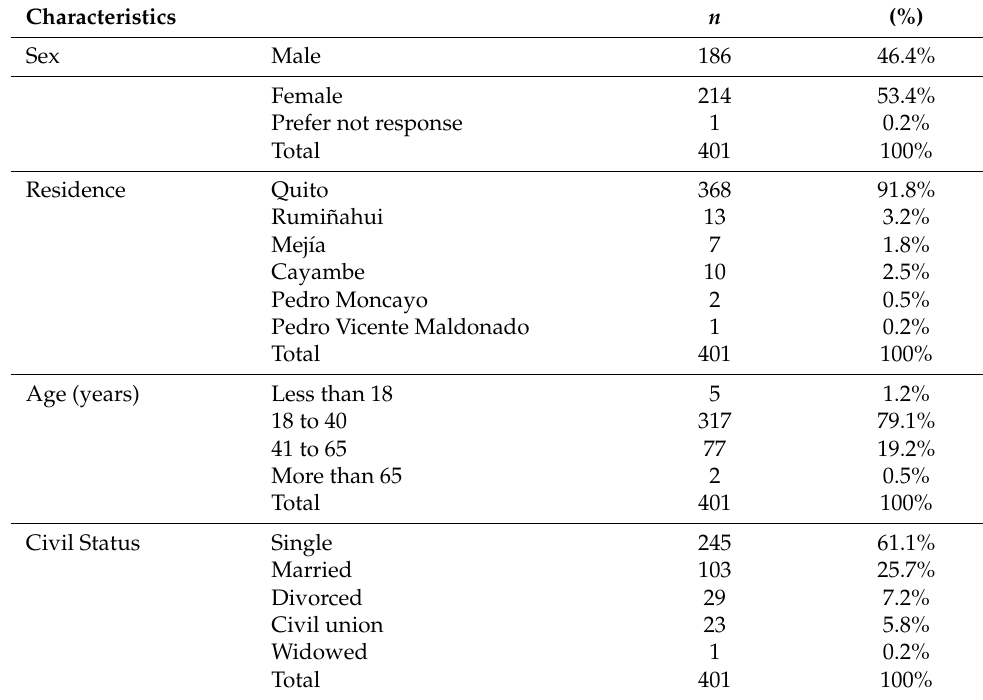
Table 1. Demographic characteristics of the